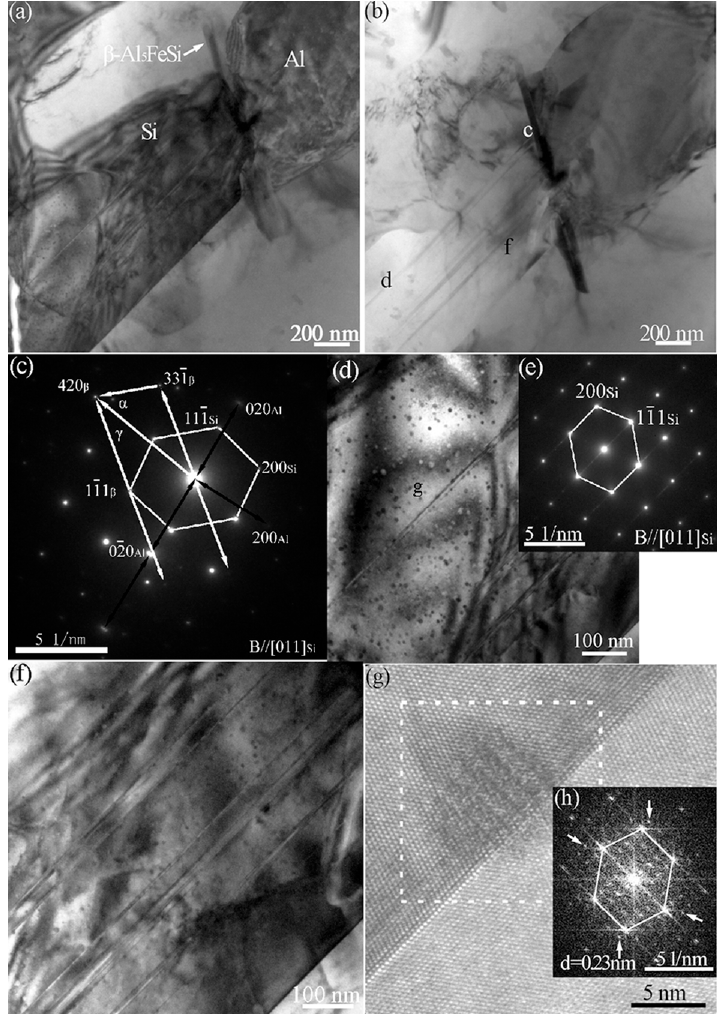
Figure 5. Microstructure of eutectic Si in Al–10Si–0.35Sb–0.015Sr alloy. ( a ) TEM dark–field image, ( b ) bright–field image, ( c ) SAED patterns of the zone marked with “c” in ( b ), subscript β denotes β –Al5FeSi compound, α and γ denote included angle between spots, ( d ) nanoparticles far from twin boundary, as denoted by “d” in ( b ), ( e ) SAED patterns for zone ”d” in ( b ), ( f ) nanoparticles adjacent to twin boundary, as denoted by “f” in ( b ), ( g ) nanoparticle penetrated by stacking faults, and ( h ) FFT of lattice image marked with dotted